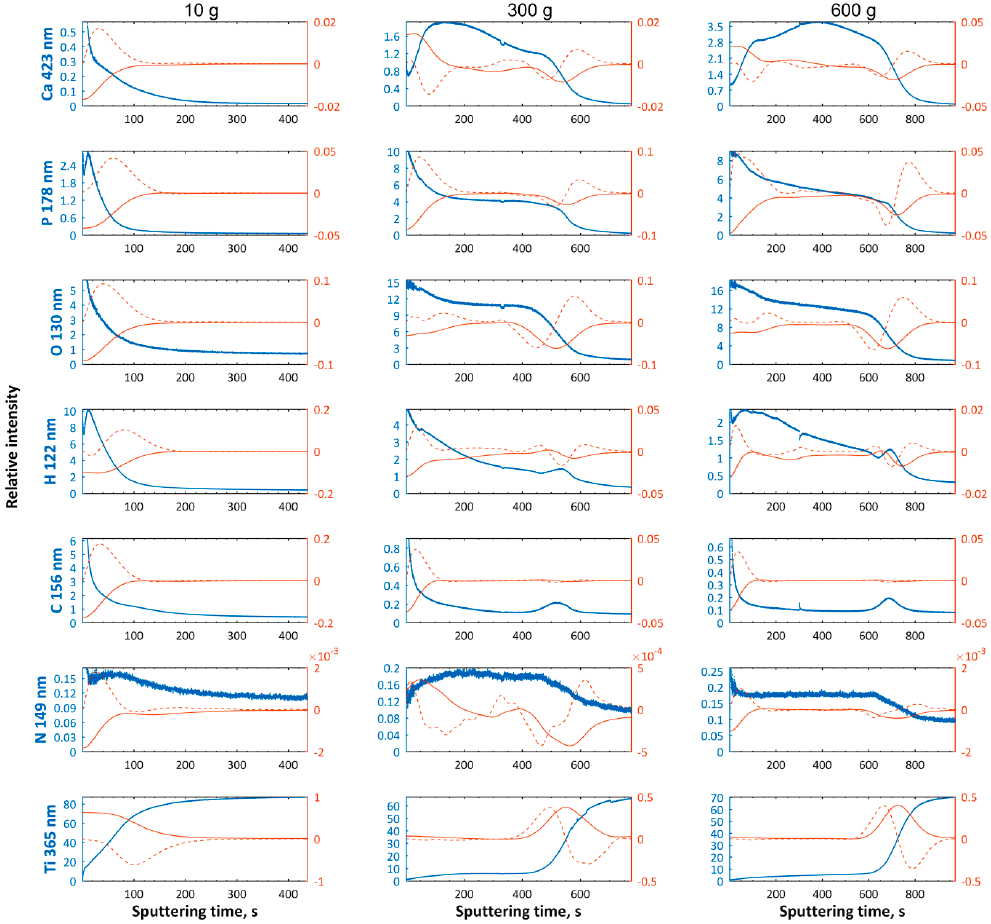
Figure 4. Glow Discharge Optical Emission Spectroscopy (GDOES) signals of calcium (Ca), phosphorus (P), oxygen (O), hydrogen (H), carbon (C), nitrogen (N), and titanium (Ti) of the porous coating formed on CP Titanium Grade 2 after PEO treatment at a voltage of 450 V in 10 g, 300 g, and 600 g Ca(NO 3 ) 2 ·4H 2 O in 1000 mL H 3 PO 4 electrolytes; blue continuous line—GDOES signal, red continuous line—first derivative, red dotted line—second derivative.